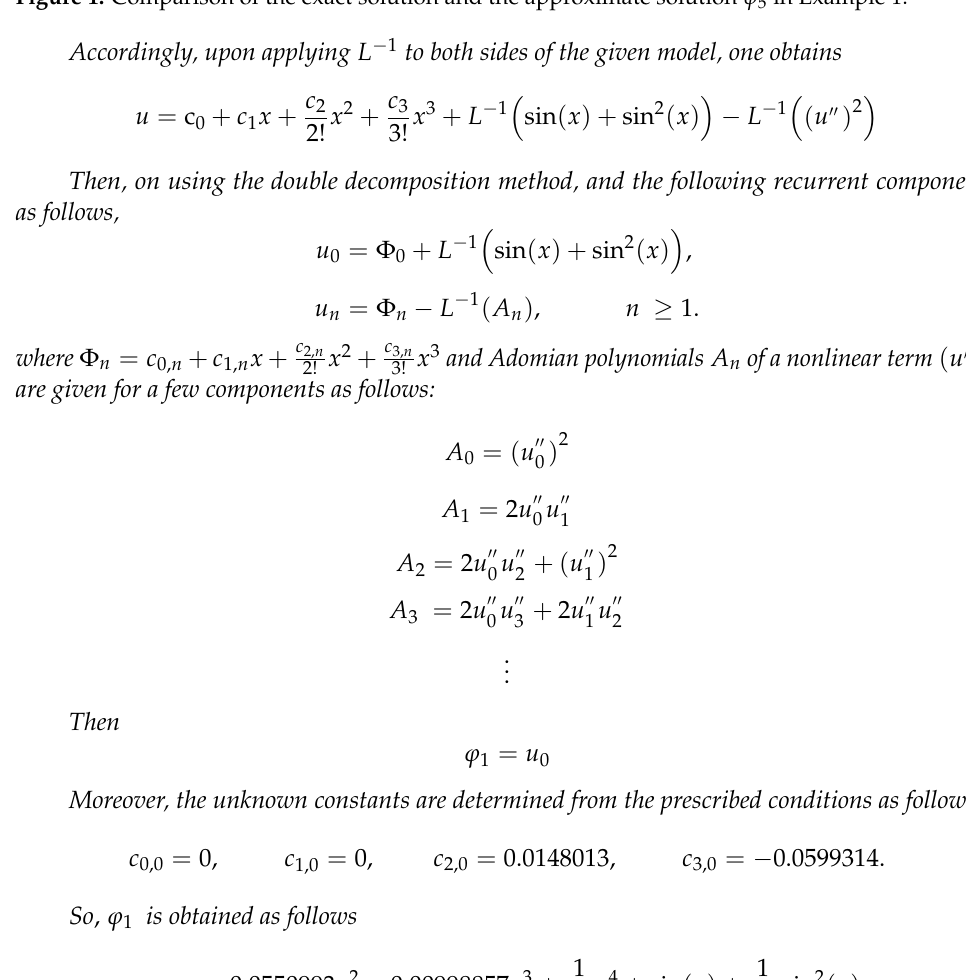
Figure 1. Comparison of the exact solution and the approximate solution 𝜑 (cid:2873) in Example 1.